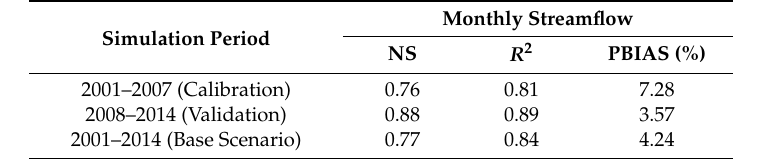
Table 6. Nash–Sutcliffe (NS) model efficiency coefficients, R ², and percent bias (PBIAS) for calibration and validation relative to monthly averaged streamflow.